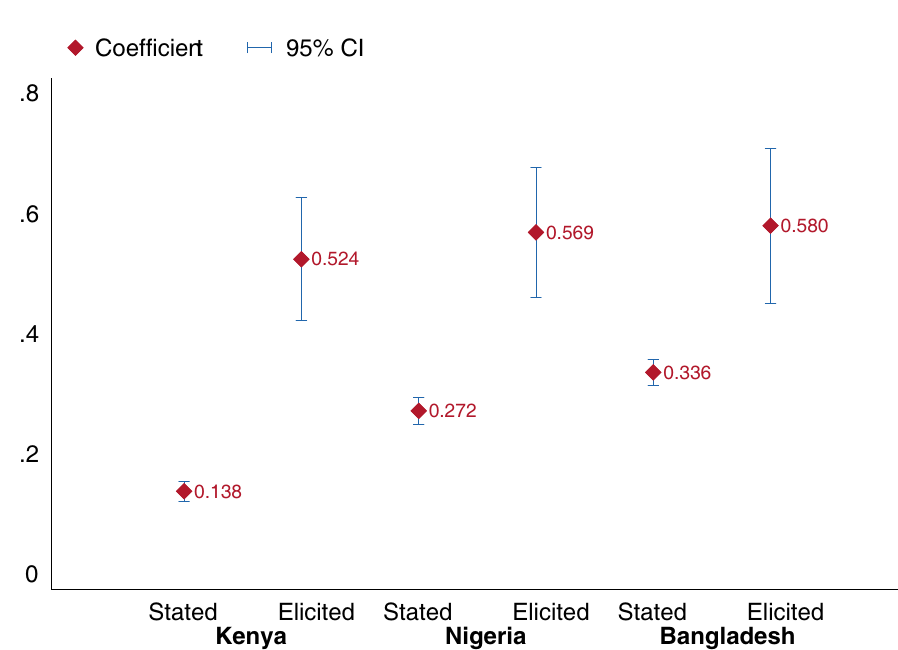
Fig 3. Stated vs. elicited mask wearing rates, by country. Notes: Means and 95% confidence intervals Stated mask non-compliance includes respondents who did not report either “All of the time” or “Most of the time” to the direct question on mask wearing practices over the past seven days. The elicited mask non-compliances are measured using list experiments. All estimates include country specific weights to ensure representability.